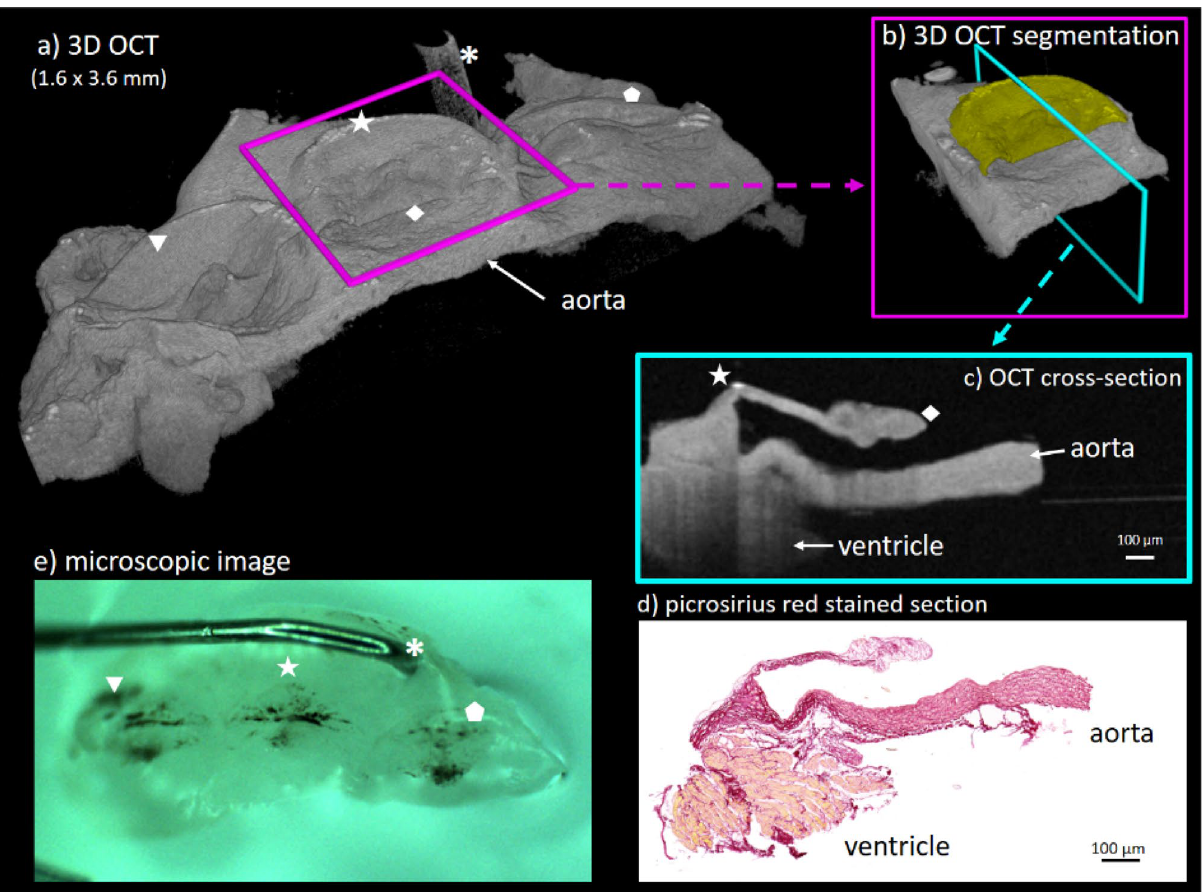
Figure 8. OCT visualization of an ex vivo aortic valve after tissue processing. The tridimensional OCT data stack enables a wide range of possibilities for image processing, including volumetric visualization, segmentation, and cross-sectional views. The OCT cross-sections were chosen to be perpendicular to the base of the acoronary leaflet. In contrast with the histological slides, OCT can be applied to native tissue and cross-sections in any orientation and, thus, can be used for tissue characterization and measurements. ( a ) 3D OCT scan of the right coronary (triangle), acoronary (star) and left coronary leaflet (pentagon). Further image processing and measurements were performed on acoronary leaflet only ( b ) and ( c )). The base of the acoronary leaflet is marked with the star and the tip of the nodulus is marked with the rhombus. To further support visual image correlation, the asterisk ( a ) and ( e )) marks the pin used to keep tissue in representative of the collagen content because the cholesterol crystals also had a SHG signal. Therefore, a correc- tion was performed to subtract the contribution of the cholesterol crystals, which was based on the fact that the crystals also generated intense CARS signal. For this purpose, all lipid structures were identified on the CARS images. First, a mean filter with a radius of 1 pixel was used to smooth the CARS images, followed by a linear contrast enhancement (min–max with 0.4% saturated pixels). A background subtraction was performed using a radius of 30 pixels. A threshold was then applied to create a binary image using the triangle method for auto- matic threshold setting. Finally, the binary CARS images were multiplied with the binary SHG images. In this way, only the structures that were both SHG-active and CARS-active (i.e., the cholesterol crystals) were retained. The percentage fraction of the area was then measured and subtracted from the percentage fraction of the area with the SHG signal for each image. A flow-chart of the whole analysis procedure with example images is dis- played in Fig. 9. Finally, a mean value for each leaflet region was obtained by averaging the percentage fraction of the area with the corrected SHG signal of all the images in the stack. The degree of organization of collagen fibers was retrieved using the plugin OrientationJ for ImageJ. The coherency parameter was used to quantify the orientation order of the fiber 81 . The coherency in an image has a value of one if the fibers are perfectly oriented in one direction and a value of zero for an isotropic structure without any orientation. Because the orientation direction of collagen fibers was different in the two halves of images, which were acquired from the midline of the leaflet, OrientationJ was applied to the left and right halves of the images (subregions 1 and 2). Histological staining. The paraffin-embedded aortic structures containing the aortic valves were sectioned at 3 µm in the longitudinal direction and stained with Movat’s pentachrome and picrosirius red (see the Sup- plementary Information). Movat’s pentachrome stain was used according to the manufacturer’s instructions (Kit